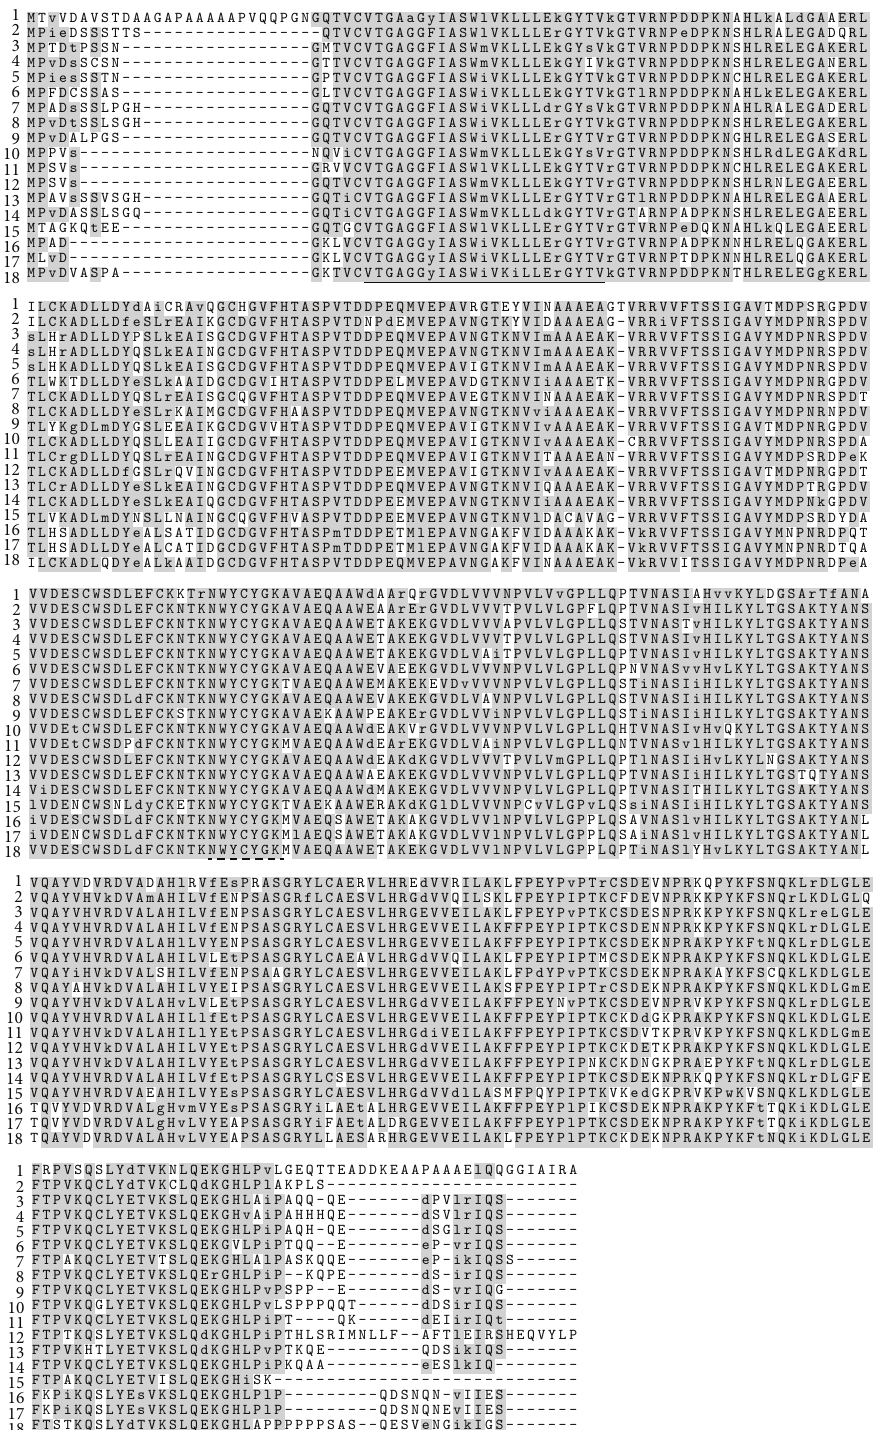
Figure 3: Multiple alignment of the deduced amino acid sequences of kenaf CCR ortholog with other plants by using ClustalW and BOXSHADE sequence alignment program in Biology WorkBench. Identical and similar amino acids are highlighted with gray. Conserved NAD(P) binding domain and catalytic domain are underlined in solid and dashed line, respectively. GenBank accession numbers are represented as follows: (1) Saccharum officinarum (CAA13176), (2) Cinnamomum osmophloeum (AFG26325), (3) Hibiscus cannabinus (ADK24219), (4) Hibiscus cannabinus (JX524276), (5) Gossypium hirsutum (ACQ59094), (6) Betula luminifera (ACJ38670), (7) Linum album (CAD29427), (8) Hevea brasiliensis (ADU64758), (9) Eucalyptus gunnii (CAA56103), (10) Codonopsis lanceolata (BAE48787), (11) Solanum lycopersicum (NP001234612),(12) Vacciniumcorymbosum (ACI14382),(13) Pyruspyrifolia (ADK62523),(14) Populustrichocarpa (CAC07424), (15) Pinus massoniana (ACE76870), (16) Brassica napus (AEK27156), (17) Arabidopsis thaliana (AAG53687), and (18) Arabidopsis thaliana